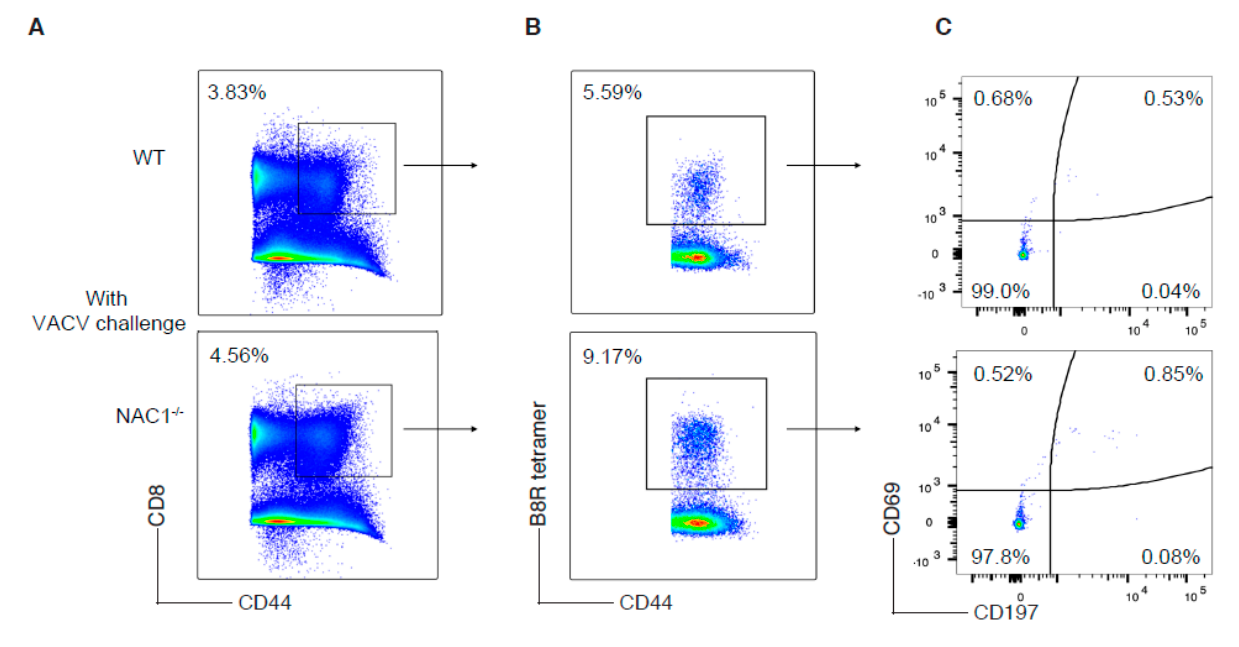
Figure 5. Analyses of CD8 + T cell memory formation. T cell memory population was investigated in WT or NAC1 − / − mice after VACV challenge. The mice were sacrificed on day 35. The spleen and LNs were dissected, smashed, and stained before flow cytometry. ( A ) Memory CD8 + T cells (CD8 + CD44 + ). ( B ) VACV-specific memory CD8 + T cells (CD8 + CD44 + B8R + ), gating on memory CD8 + T cells. ( C ) Tissue-resident memory (CD44 hi CD69 hi CD197 low ), central memory (CD44 hi CD69 low CD197 hi ) and effector memory (CD44 hi CD69 low CD197 low ) T cells, gating on VACV-specific memory CD8 + T cells. The plotting data shown are representative of three identical experiments ( n = 5).